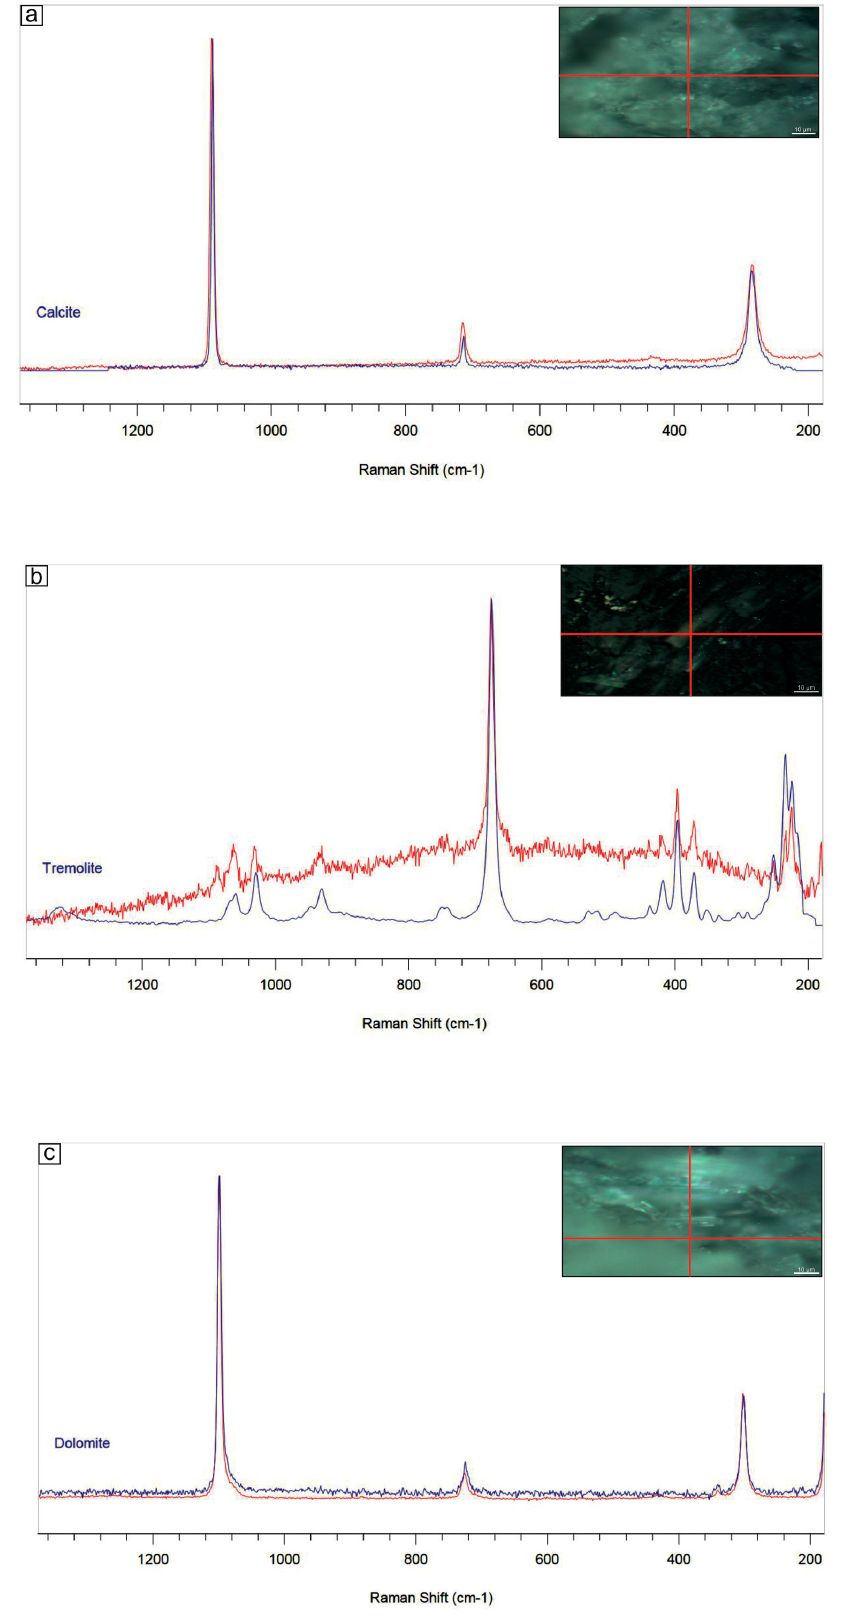
Figure 5. Micro-Raman spectra of selected areas of the Karibib white marbles, showing ( a ) calcite; ( b ) tremolite; and ( c ) dolomite as constituting mineral phases (red spectra). The blue reference spectra are after [52]. Pictures of boxes indicate the investigated